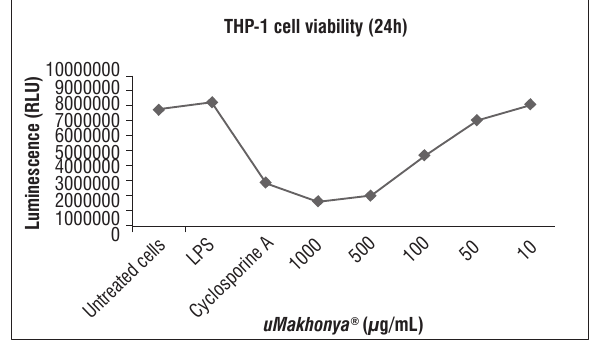
Figure 2: Cell viability of LPS stimulated THP-1 monocytes treated with doses of uMakhonya ® ranging from 1000 µg/mL to 10 µg/mL.